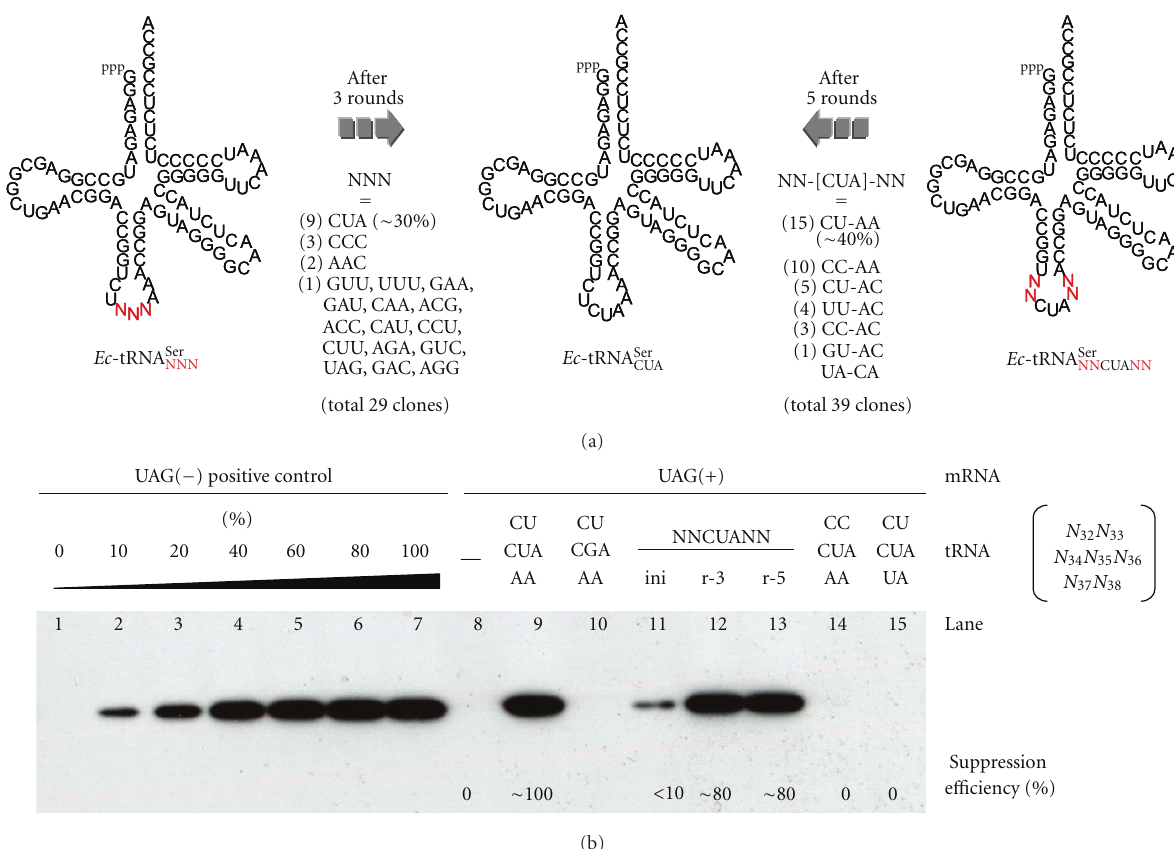
(a) of fused templates (Figure 1(a), NNN = NNN with